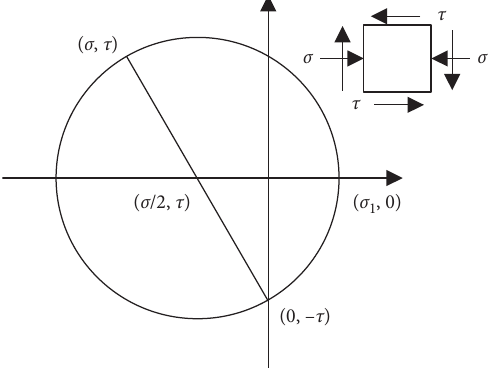
Figure 3: Principal